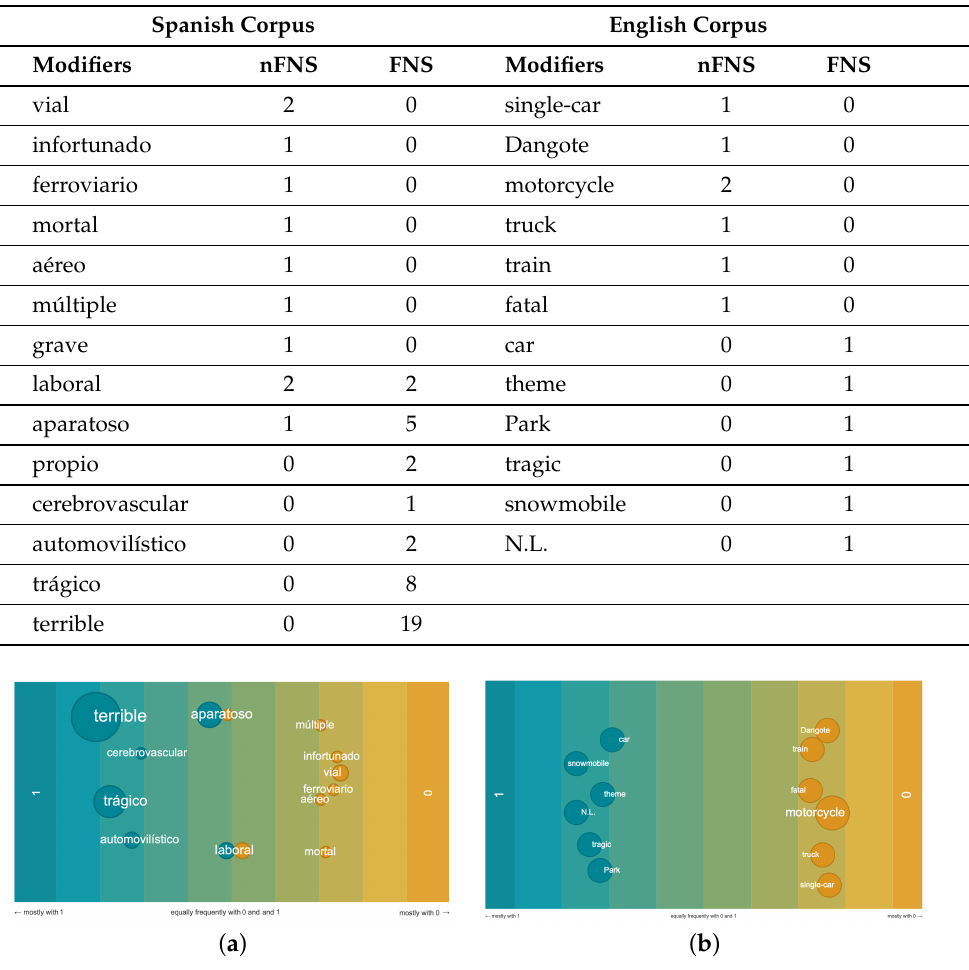
Table 3. Modifiers of ACCIDENTE and ACCIDENT in the corpora.